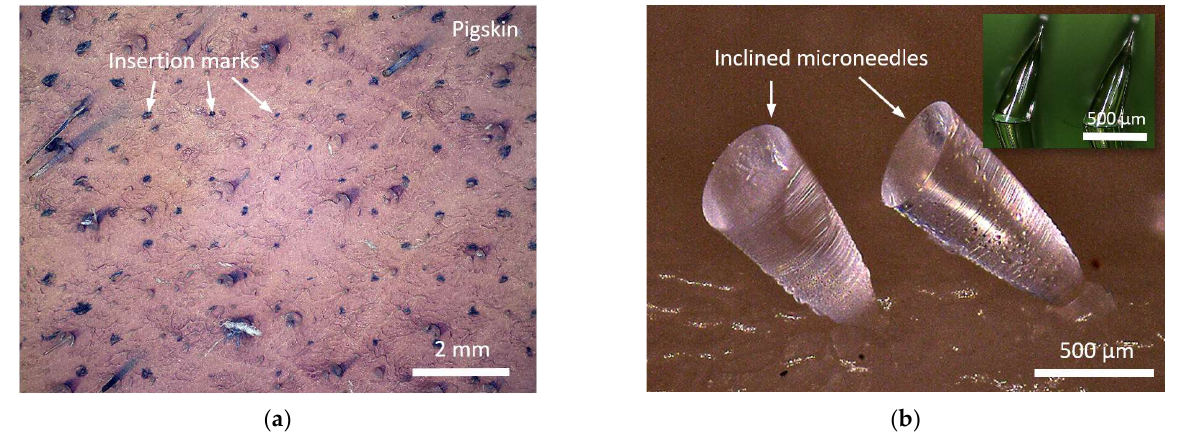
Figure 6. Skin insertion test results. ( a ) Pigskin inserted by 180 units PLA microneedles array with first bell-tip. ( b ) Successful tips insertion and needle body detachment using resin-based inclined microneedles array.